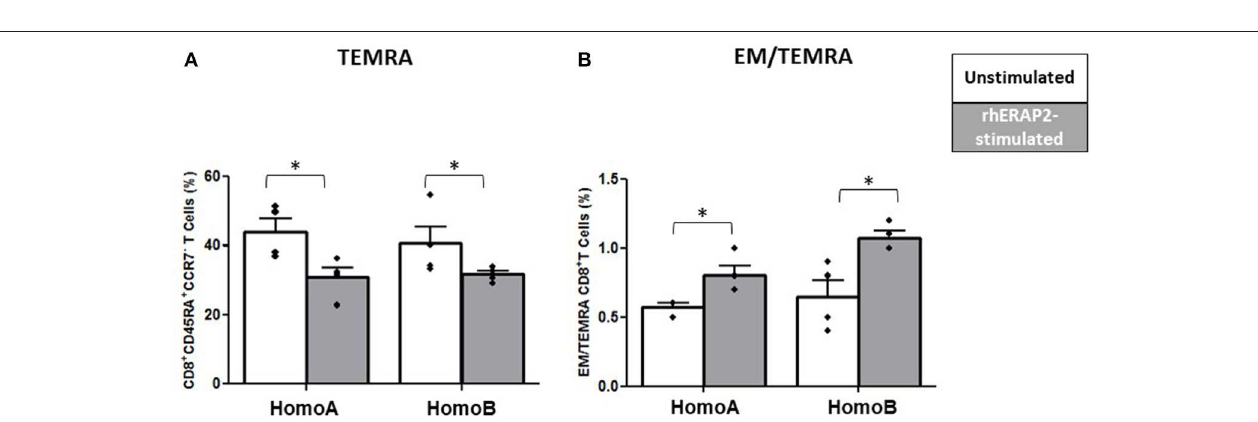
FIGURE 6 | The percentage of CD8 + effector memory re-expressing CD45RA (TEMRA: CD45RA + CCR7 − ) T cells was reduced in in vitro rhERAP2-treated PBMCs. (A) Percentage of CD8 + TEMRA in 24 h-rhERAP2 untreated (white bars) or treated (gray bars) PBMCs from 4 HomoA and 4 HomoB subjects. (B) Ratio between EM (Effector Memory CD45RA − CCR7 − ) and TEMRA CD8 + T cells in 24 h-rhERAP2 untreated (white bars) or treated (gray bars) PBMCs from 4 HomoA and 4 HomoB subjects. Mean values and SEM are shown. * p <